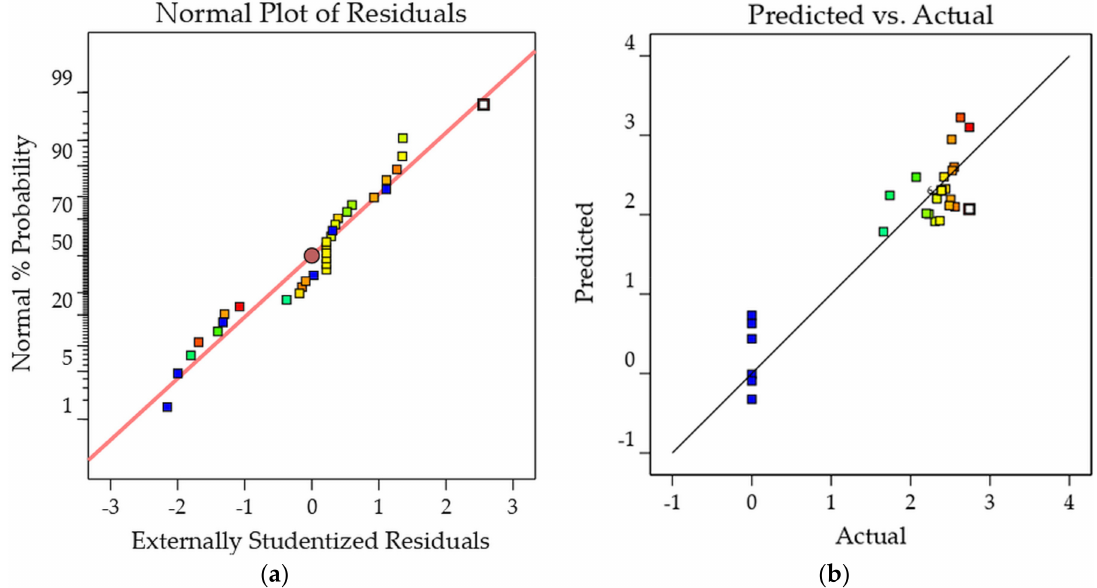
Figure 6. ( a ) Normal plot of residual for P. aeruginosa cell inhibition.; ( b ) Predicted vs. actual plot for P. aeruginosa inhibition. The color scale shows the value of P. aeruginosa in the quadratic model from blue (0.000) to red (2.740).